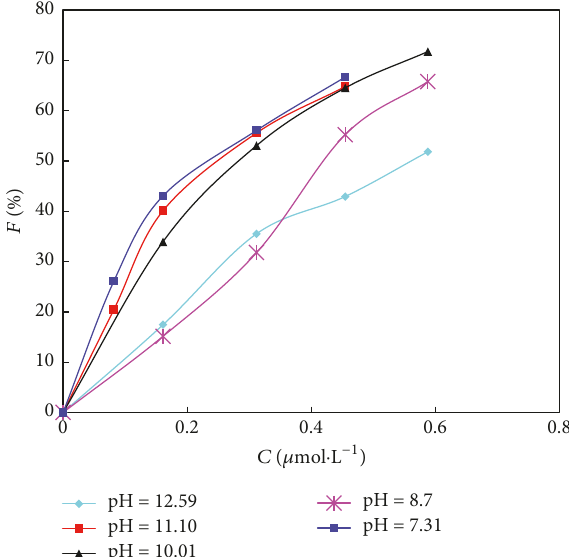
Figure 5: O 2 ∙− scavenging activity of FK-Gly and FK.